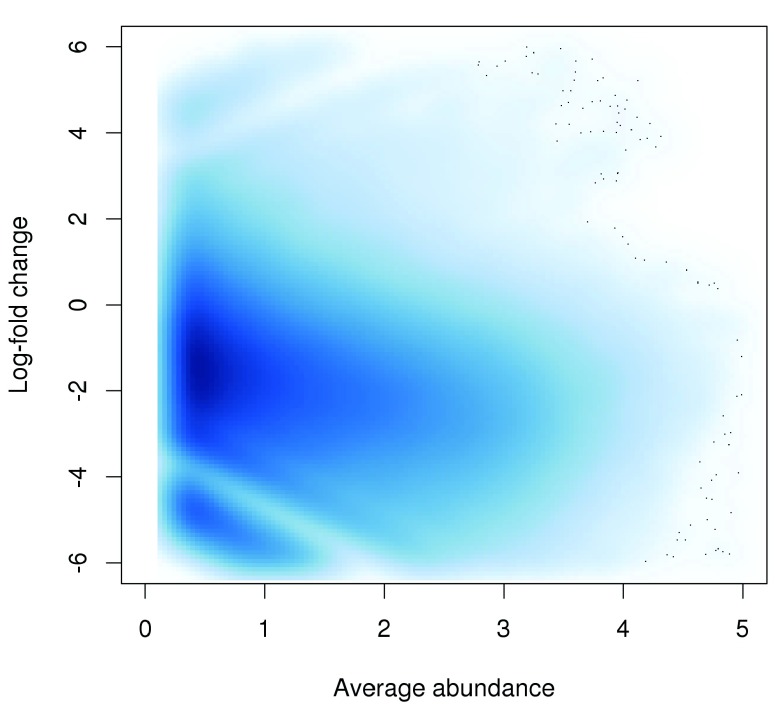
Abundance-dependent trend in the log-fold change between two H3K9ac libraries (mature B over pro-B), across all windows retained after filtering.